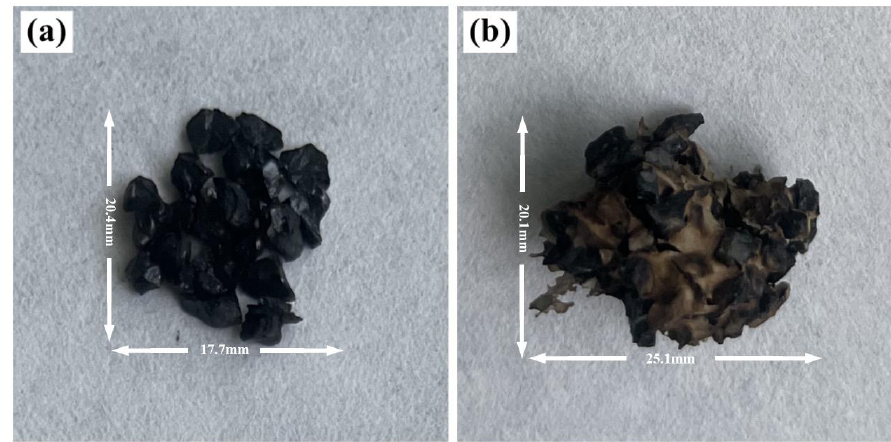
◦ C for 1 h: ( a ) coal, ( b ) coal + Figure 14. Partial samples at 300 °C for 1 h: ( a ) coal, ( b ) coal + LMP-Bt. Figure 14. Partial samples at 300